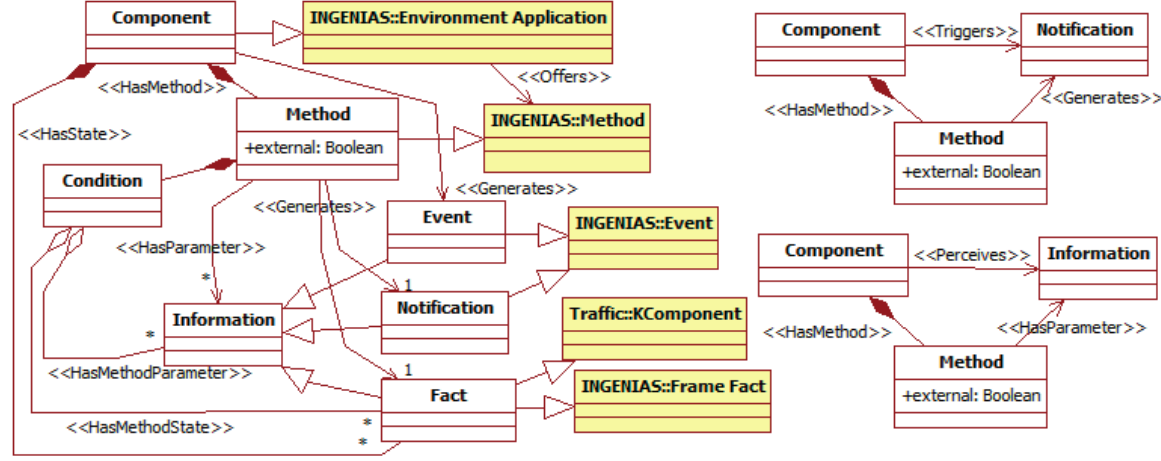
Figure 3. Partial ITS metamodel. Component related